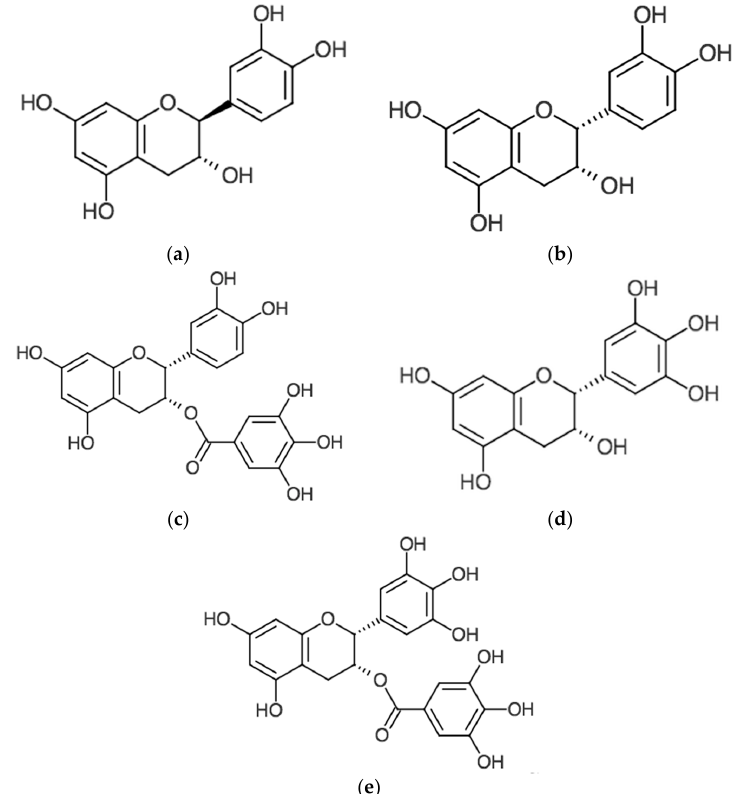
Figure 2. Chemical structures of major tea polyphenols. ( a ) (+)-Catechin (C); ( b ) ( − )-Epicatechin (EC); ( c ) ( − )-Epicatechin gallate (ECG); ( d ) ( − )-Epigallocatechin (EGC); ( e ) ( − )-Epigallocatechin gallate (EGCG).